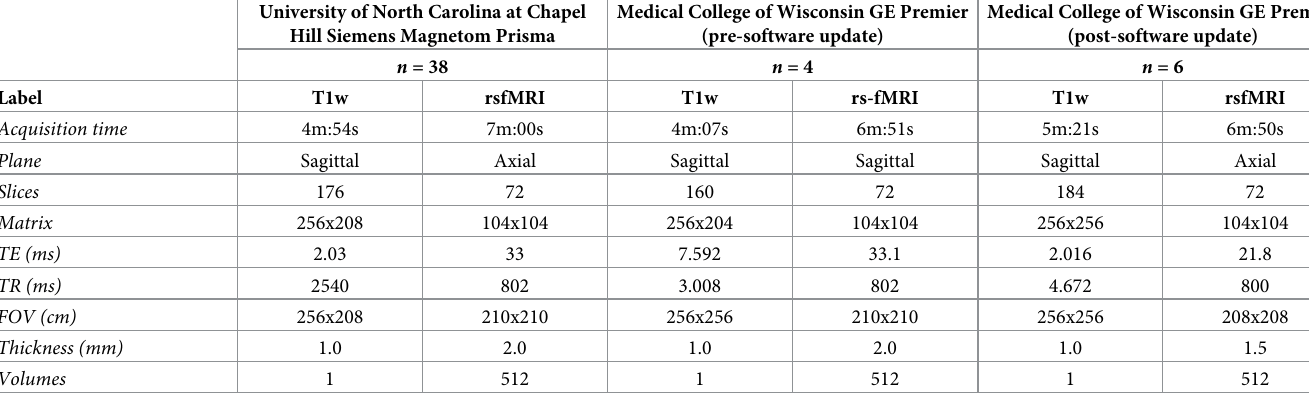
Table 1. Magnetic resonance imaging (MRI) acquisition parameters across study